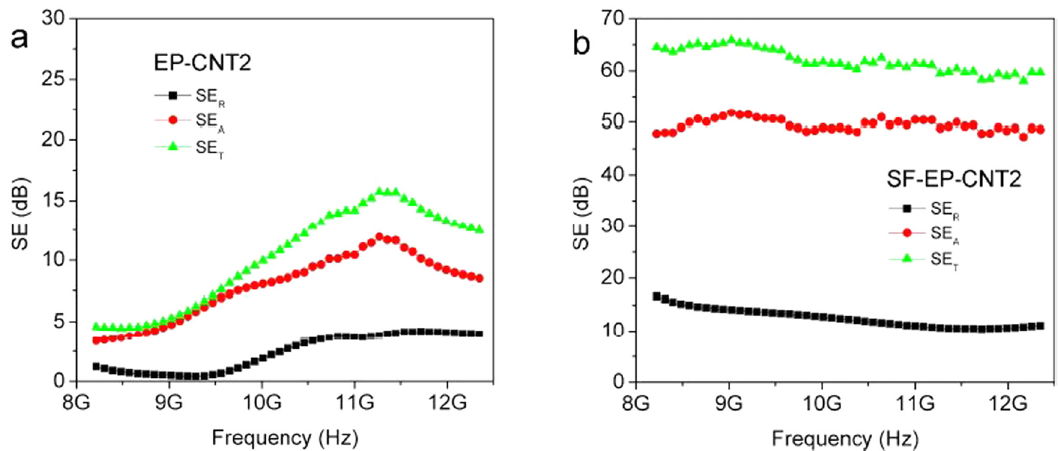
Figure 4: Variations in the total EMI SE, SE A , and SE R of the ( a ) EP - CNT2 and ( b ) SF - EP - CNT2 samples over the X band [ 101 ] .